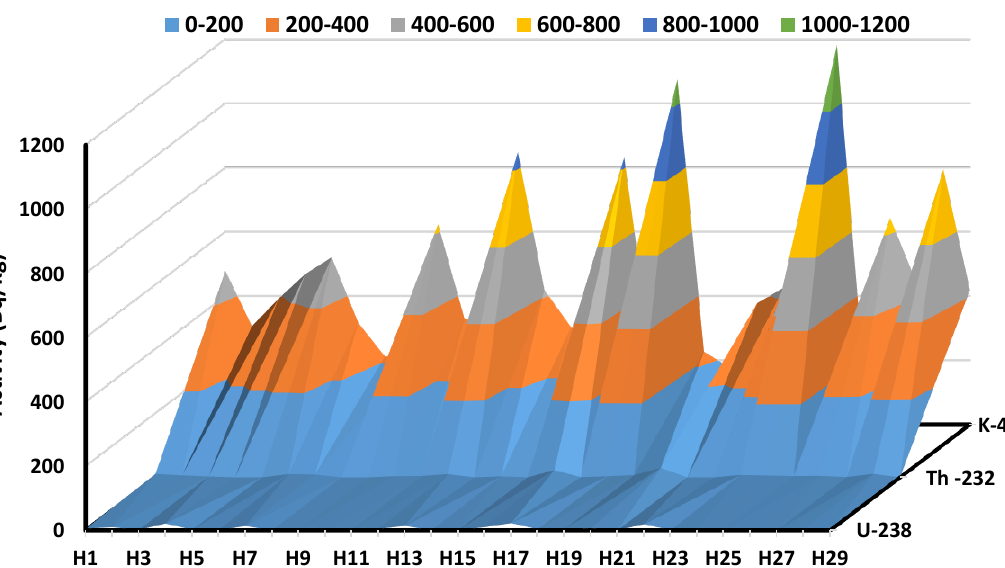
Figure 3. The activity concentration for 238 U, 232 Th, and 40 K in medicinal plant samples (Bq⁄kg). From the current research, we can see that the concentration levels of 238 U varied from BDL to 20.71 ± 1.52 Bq/Kg as observed in 15 plant species exceeding BDL values with an average of 7.25 ± 0.52 Bq/Kg. Thyme herb (H4) has the highest 238 U concentration. 232 Th concentrations ranged from BDL to 29.35 ± 1.33 Bq/Kg, as observed in 10 plant species with concentrations greater than BDL values, with an average of 7.78 ± 0.633 Bq/Kg. Cinnamon (H20) has the highest 232 Th concentration. The 40 K activity concentrations were recorded between 172 ± 5.85 Bq/Kg turmeric and 1181.2 ± 25.5 Bq/Kg cinnamon with an average value of 471.4 ± 11.33 Bq/Kg. Since some of the studied samples have